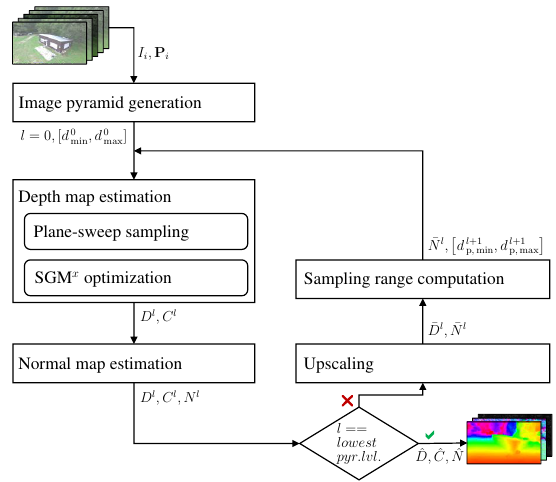
Figure 1. Overview of the proposed methodology. Given five images I i of an input sequence, we perform hierarchical SfM to estimate a depth, confidence and normal map ( ˆ D, ˆ C, ˆ N )